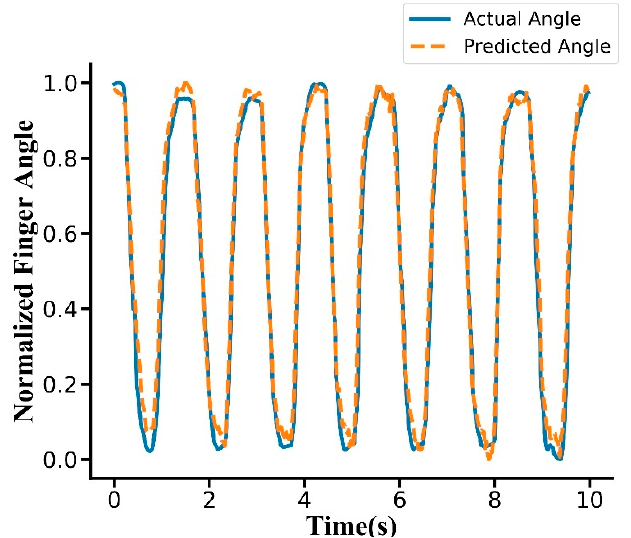
Figure 5. Typical trial showing actual and predicted normalized finger angles (subject 10, thumb). The R 2 score for this trial was 0.965. Finger angles were normalized from 0 and